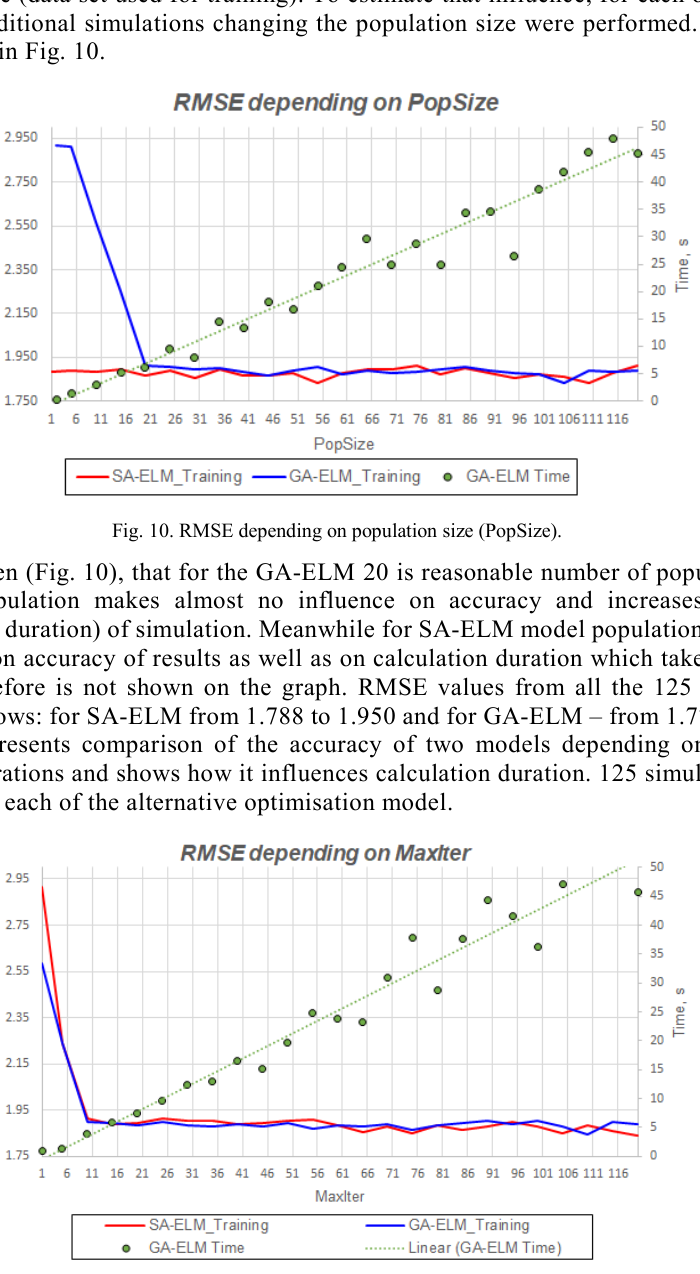
Fig. 11 . RMSE depending on Max